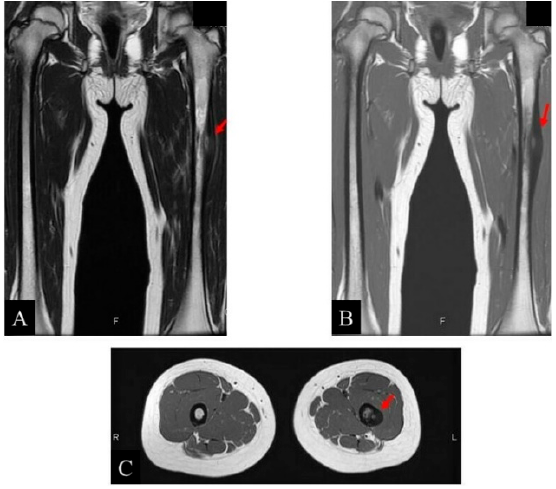
Figure 2. Images of the left femur of a 12-year-old girl: ( A ) coronal magnetic resonance imaging (MRI) T1-weighted image; ( B ) coronal MRI T2-weighted image; and ( C ) axial MRI T2-weighted im- age.